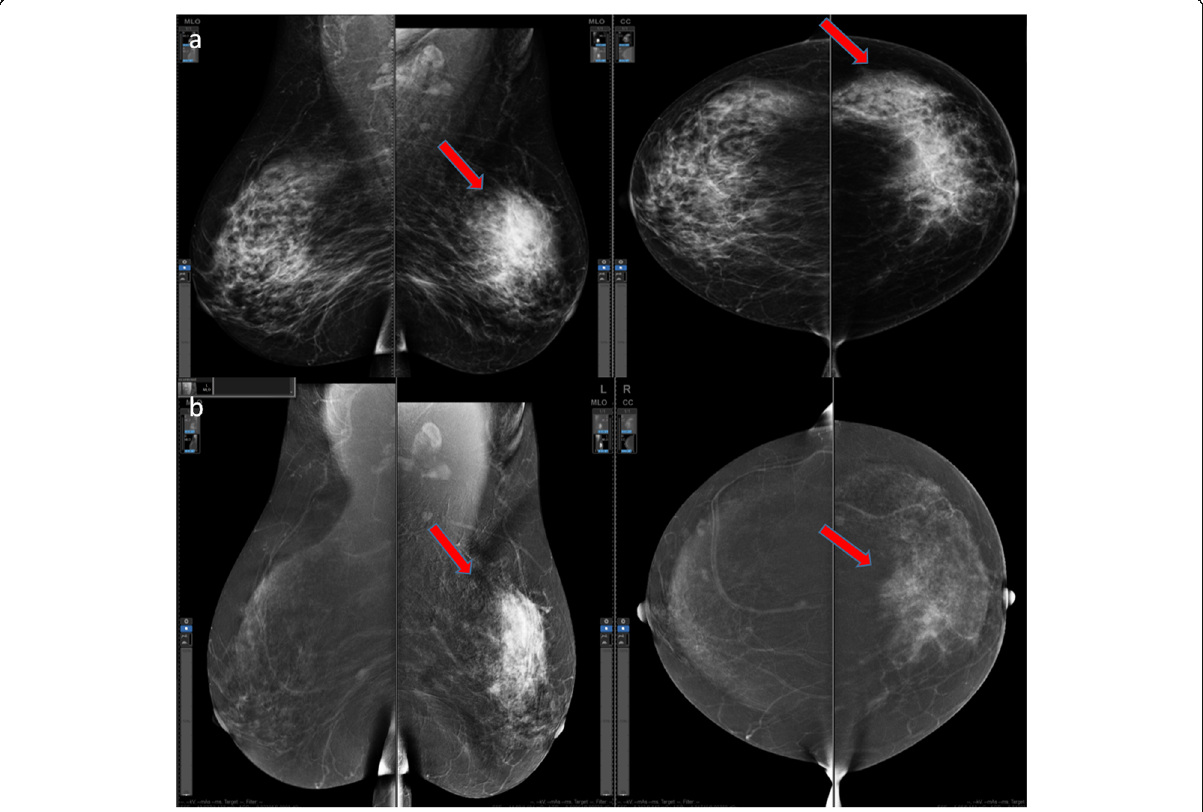
Fig. 3 A 48-year-old female coming from the left breast lump with heterogeneous dense breasts. a FFDM showed heterogeneously dense fibro- glandular parenchyma ( ACR C ), no right breast lesions ( BIRADS 1 ) and left UOQ focal asymmetry with left retracted nipple ( BIRADS 4 ). b CESM showed no right-enhancing lesions ( BIRADS 1 ) and left heterogeneous segmental non-mass enhancement seen radiating from the nipple (with the line of cleavage) backwards with left retracted nipple ( BIRADS 5 ). Histopathology : left breast IDC2. Comment : CESM proved the malignant nature of breast lesion and showed an underlying lesion not seen in